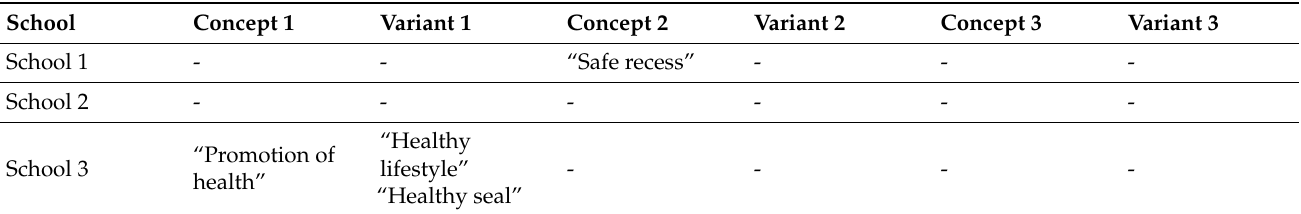
Table 3. Presence and absence of